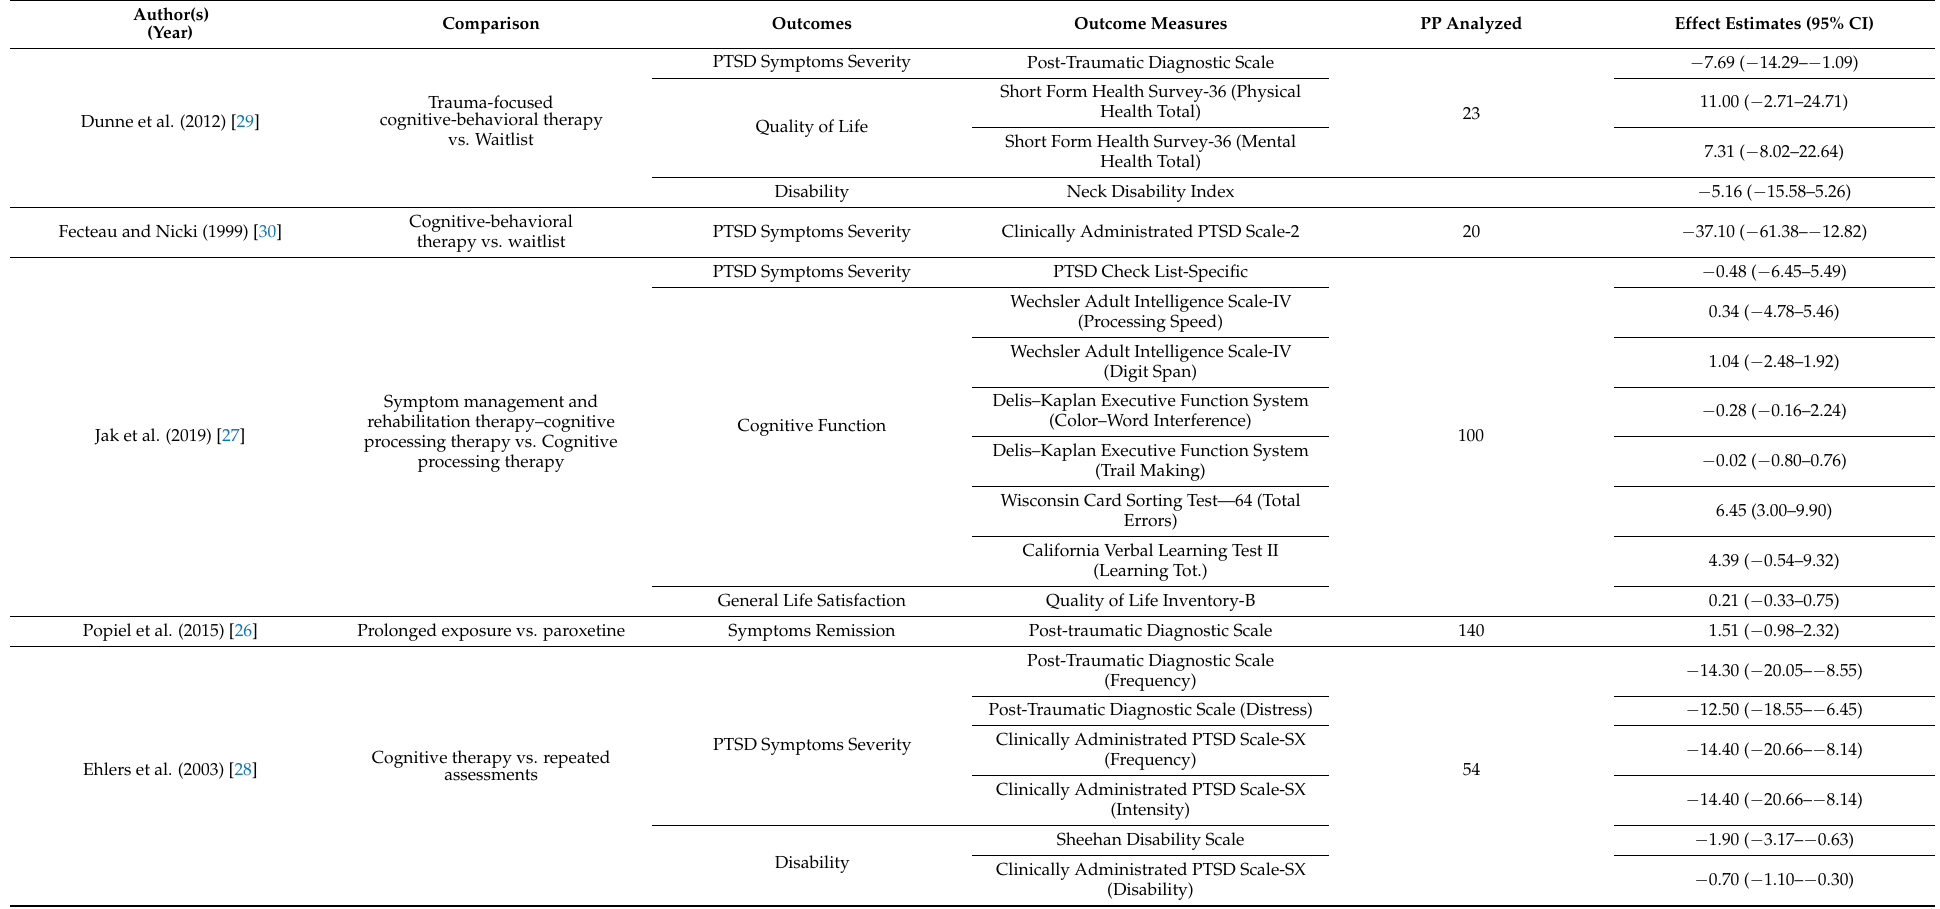
Table 2. Outcomes and effect estimates of included